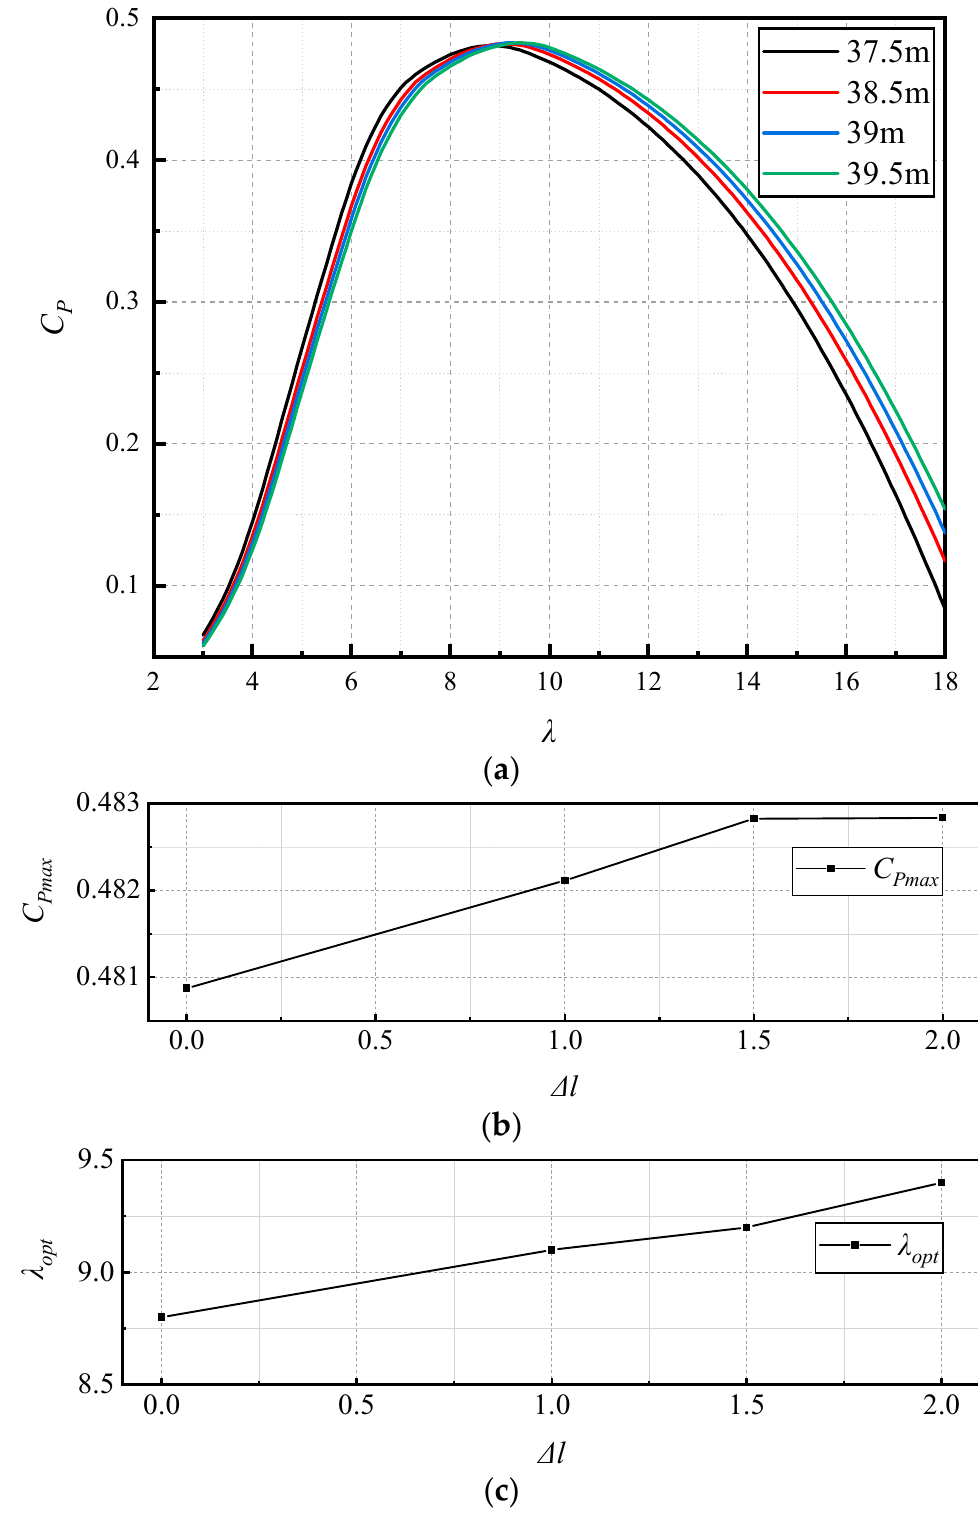
Figure 4. Variation of C P : ( a ) C P - λ curve of turbines with different blade lengths; ( b ) Variation of C Pmax with the blade extension length; ( c ) Variation of λ opt with the blade extension length.